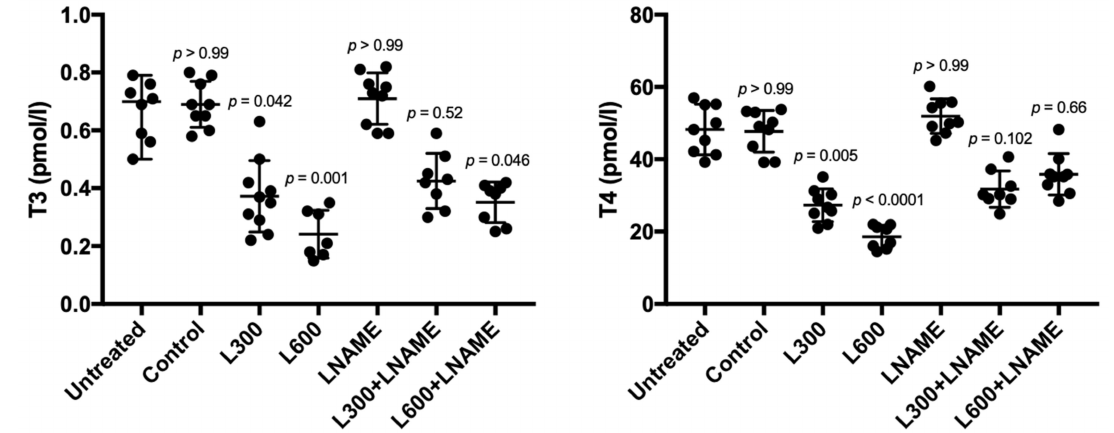
Figure 2. Thyroid hormones levels. Fourteen days following orthodontic tooth movement, trunk blood was collected for serum preparation. Prepared serum was stored at − 70 ◦ C until measured by radioimmunoassay. Multiple comparisons were based on Kruskal–Wallis test and Dunn’s correction. p -values show the changes compared to the normal non-OTM group. Comparison of L600 with L600 + LNAME is p = 0.15 but for consistency not shown in Figure 2. Data are shown as dot blot with median and 95% CI.